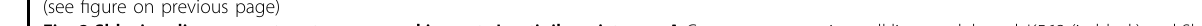
Fig. 2 Shh signaling promotes stemness and imparts Imatinib resistance. A Cartoon representing cell line model used, K562 (in black) and Shh- K562 (in green). B Shh and Gli-1-mRNA expression in Shh-K562 determined using RT-PCR, normalized to K562. Bar represents mean ± SD from three biological repeats. Western blot demonstrating expression of Gli-1 and Shh proteins in K562 and Shh-K562. Actin is used as loading control. C Levels of stemness markers, CD73, CD34, CD117, and CD90, and myeloid differentiation marker (CD38) in the Shh-K562 cell line determined using RT-PCR, normalized with K562. Bar represents mean ± SD from two biological repeats. D Representative images of FACS-based analysis of CD90, CD34, and CD73 expression in K562 and Shh-K562. Experiment was done with two biological and technical repeats with similar results. E Concentration curve for Imatinib to identify IC50 at 72 h, Shh-K562 (green line) compared to K562 (control; black line graph). Line graph represents mean ± SD from three biological repeats. F Images demonstrating colony forming units (CFU) using K562, Imatinib-treated K562 (TK562), Shh-K562, and Imatinib-treated Shh-K562 (TShh-K562). Graph represents average area of the colonies (30 – 100 colonies per condition) from duplicate experiments, in Log 10 scale. For all images, P values, *<0.05, **<0.01, and ***<0.001. Statistical analysis done using t